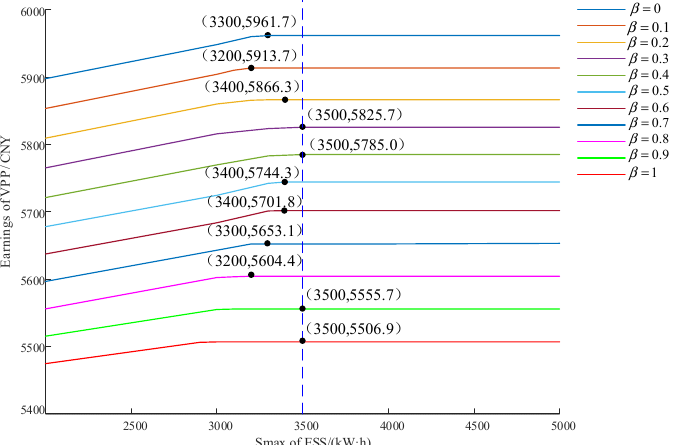
Figure 11. Income of VPP operators under the maximum capacity of different energy storage equip- ment.